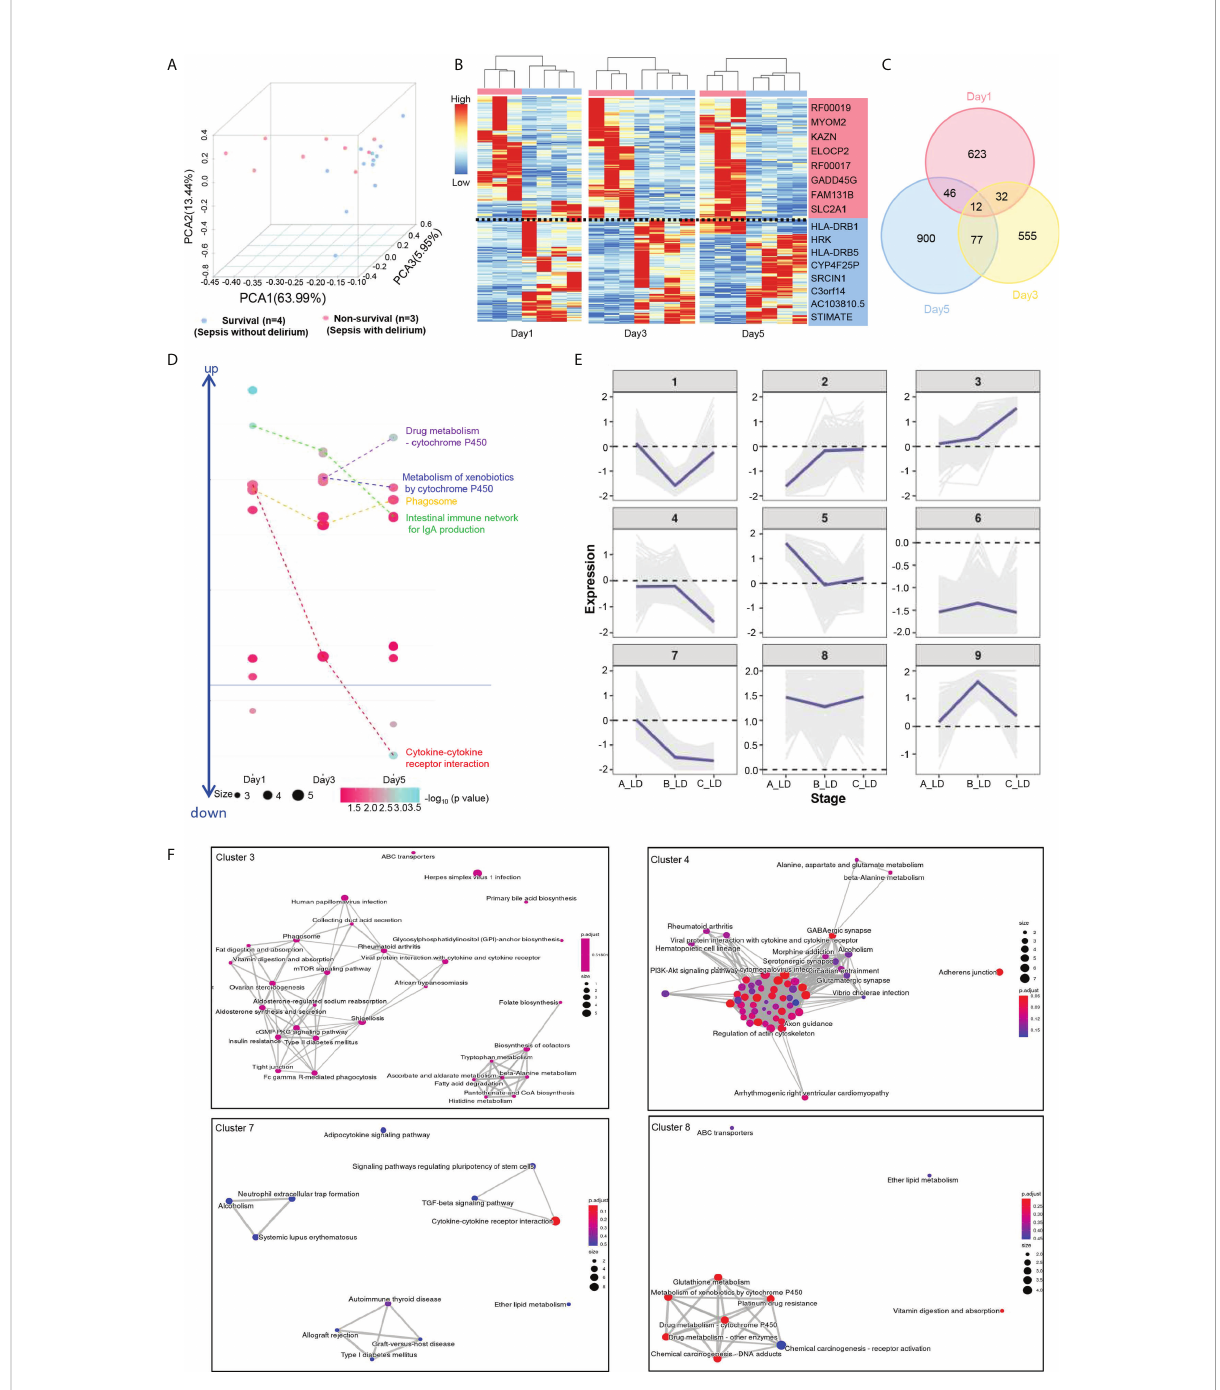
FIGURE 2 Transcriptional signatures of SAD and K-means analysis of DE genes. (A) PCA plot for RNA-seq data. All survival samples (blue dots) and nonsurvival samples (red dots) are shown. (B) Heat map visualization of DE genes ( p value <.05 and fold change ≥ 2) between survival (blue) and nonsurvival (red) patients. (C) Venn diagram of DE genes between survival and nonsurvival groups. (D) The signi fi cantly enriched KEGG pathway for each group submitted DE genes are shown at days 1, 3, and 5. (E) Expression trends of DE genes from days 1 – 5. Genes were grouped as nine clusters with k-means clustering according to their expression patterns. The expression of each gene was calculated by normalized counts with the formula as follows. Exp (per gene) = log2 (AVG- livability/AVG- mortality). Exp (per gene) : the expression value of each gene; AVG-mortality: average gene expression of nonsurvival; AVG-livability: average gene expression of survival. (F) The signi fi cantly enriched KEGG pathway for clusters 3, 4, 7, and